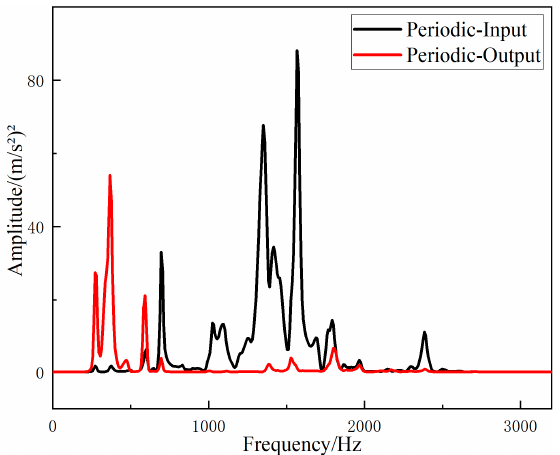
Figure 17. Frequency domain input and output signal of the periodic structure support.